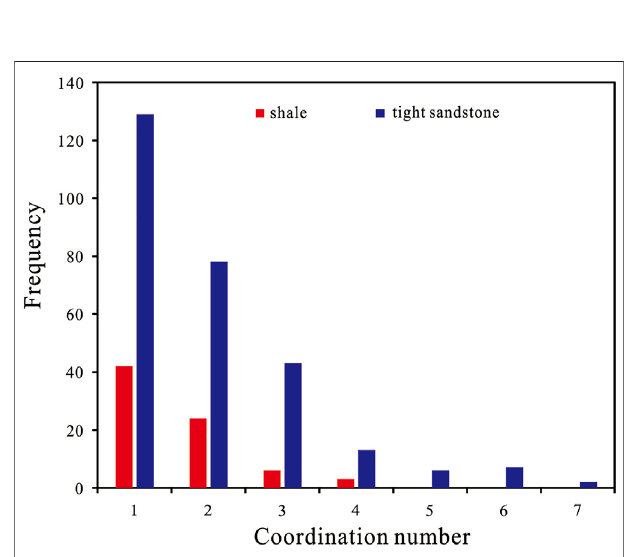
FIGURE 13 | Histograms of frequency distributions of coordination numbers for shale and tight sandstone samples.